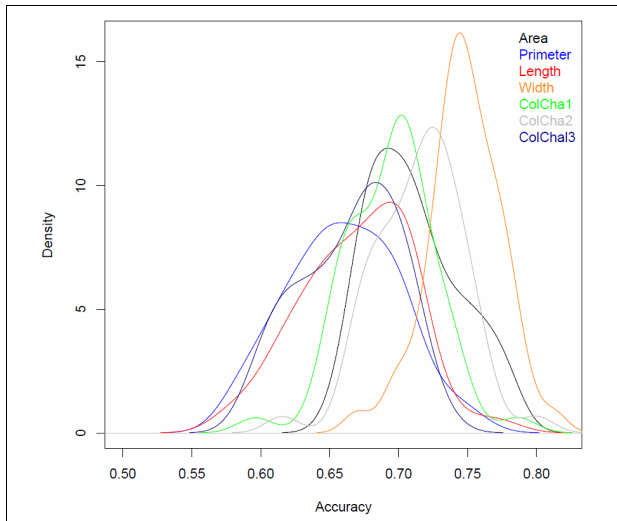
FIGURE 3 | Densities for prediction accuracy using validation set for grain traits of bread wheat genebank accessions.